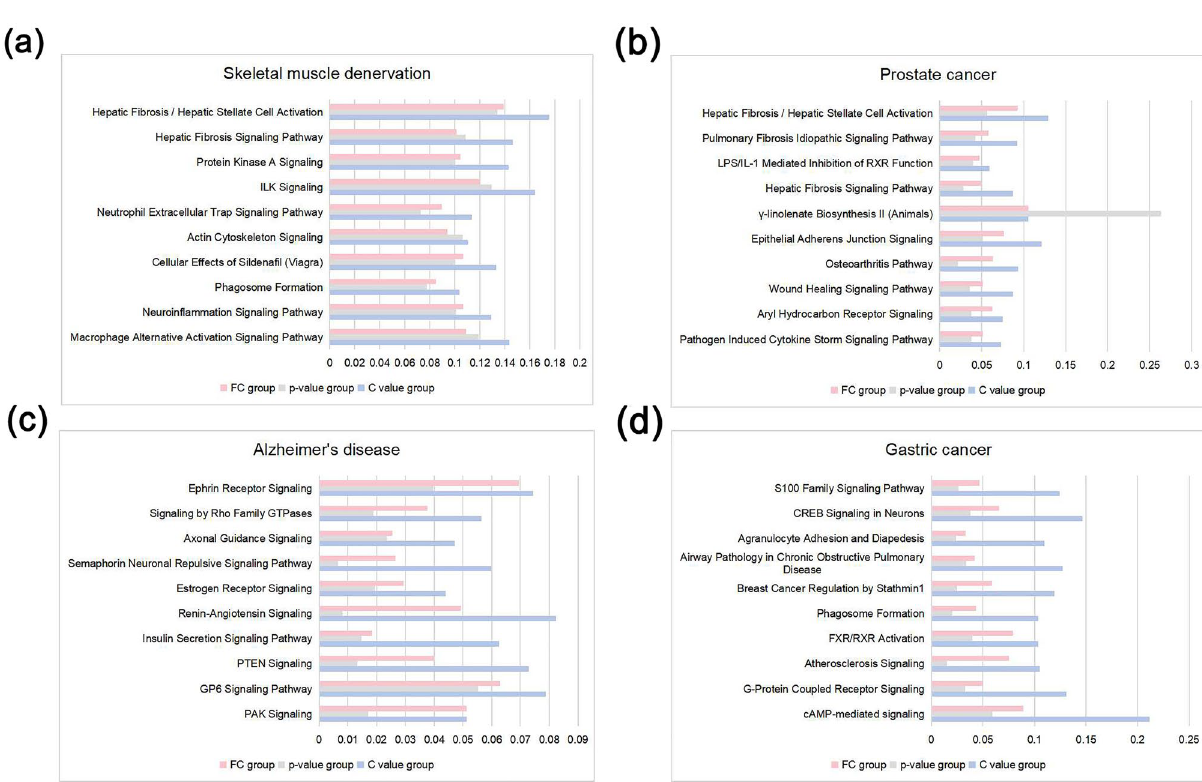
Figure 1. Proportion of three groups in each IPA canonical pathway ( a ) Skeletal muscle denervation. ( b ) Prostate cancer. ( c ) Alzheimer’s disease. ( d ) Gastric cancer. (FC group: the collection of the top10 FC miRNAs’ predictive target mRNAs; p-value group: the collection of the top10 p-value miRNAs’ predictive target mRNAs; C value group: the collection of the top10 C value miRNAs’ predictive target mRNAs). Picture drawn by Microsoft